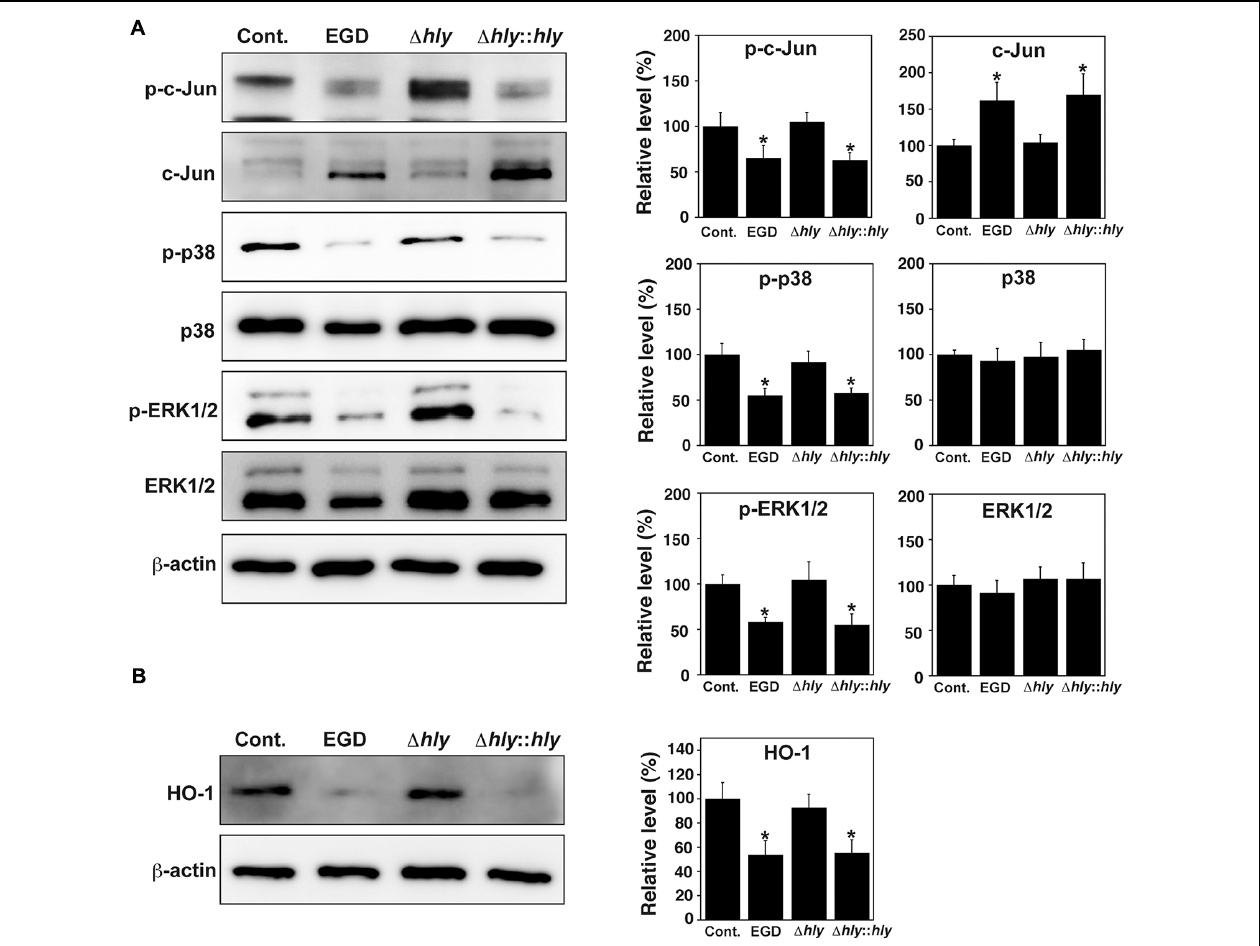
FIGURE 5 | LLO contributes to dephosphorylation of MAPK family proteins and downregulation of HO-1. (A) Expression of MAPK family proteins. TG cells were infected with or without (Cont.) L. monocytogenes wild-type strain EGD, LLO deletion mutant ( (cid:2) hly ), or LLO-complemented strain ( (cid:2) hly :: hly ) for 3 h. Expression of the indicated proteins was detected by immunoblotting. β -actin was used as an immunoblotting control. Phosphorylated c-Jun, p38, and ERK1/2 are indicated as p-c-Jun, p-p38, and p-ERK1/2, respectively. (B) Expression of HO-1. TG cells were infected with the L. monocytogenes strains described above for 6 h. Expression of HO-1 was detected by immunoblotting. β -actin was used as an immunoblotting control. (A,B) The intensity levels of each protein expression were measured using Multi gauge software and normalized by the value of β -actin. Relative values to the intensity without infection (Cont.) were shown. All values represent the means and SD of three assays. ∗ P < 0.05 compared with Cont. by post hoc Tukey–Kramer test.